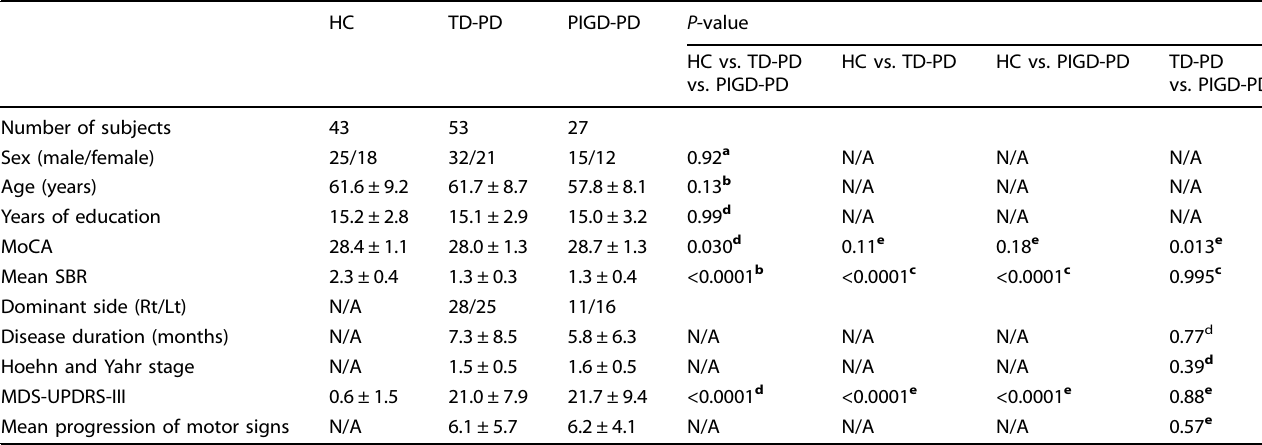
Table 1. Demographic characteristics of the